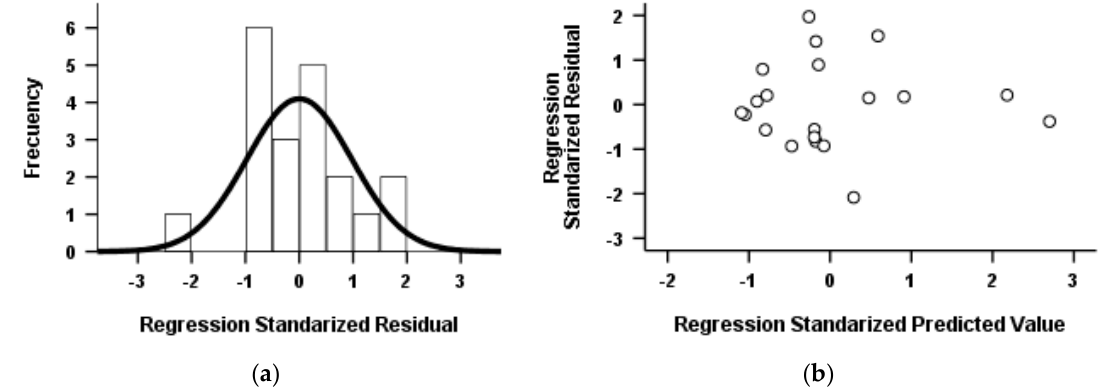
Figure 7. Graphs to verifying both normality and independence of residues: ( a ) histogram of the standardized residual and ( b ) scatterplot of the standardized residuals with the standardized predicted values.